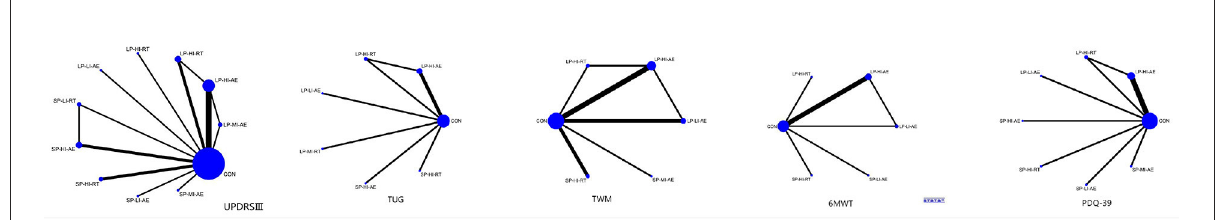
FIGURE4 Network of evidence UPDRS-III outcome. SP-MI-AE, short period moderate intensity aerobic exercise; SP-LI-AE, short period low intensity aerobic exercise; SP-HI-RT, short period high intensity resistance training; SP-HI-AE, short period high intensity aerobic exercise; SP-LI-RT,